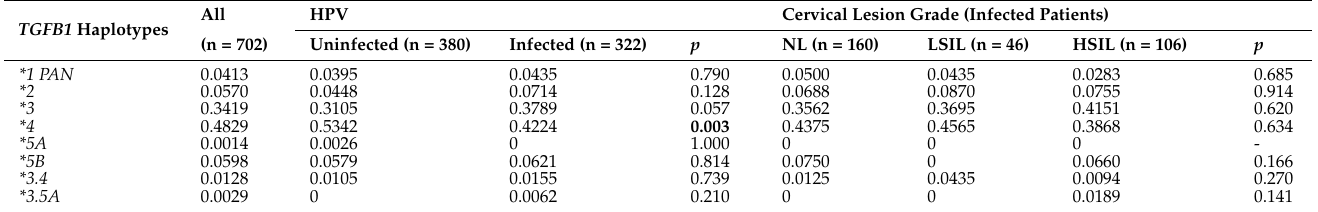
Table 3. Comparison of the frequency of TGFB1 haplotypes in HPV and cervical lesion